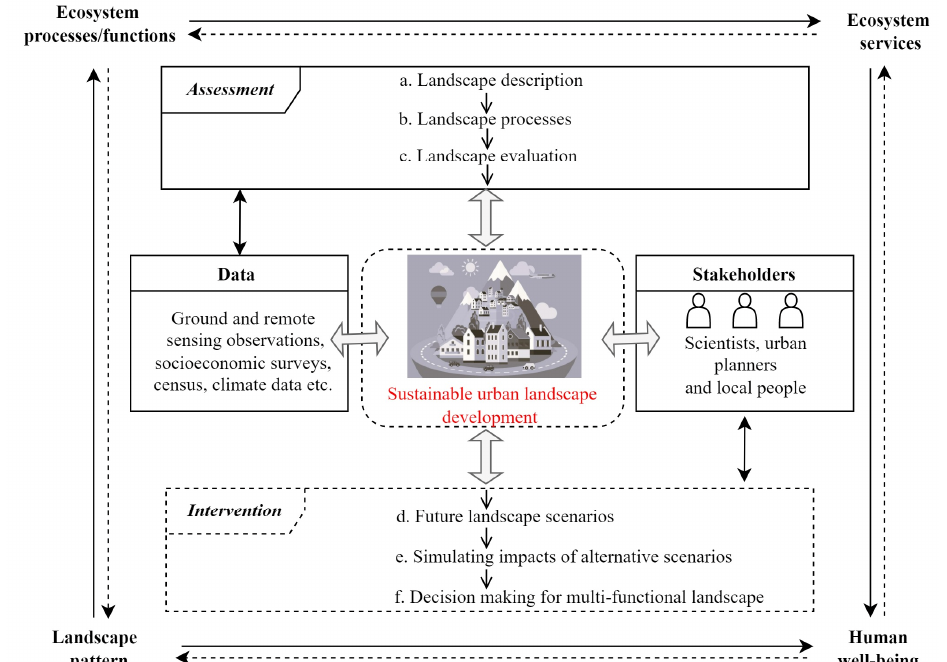
Figure 8. A conceptual framework for integrating landscape ecology and Geodesign for sustainable urban landscape development in the Himalaya.